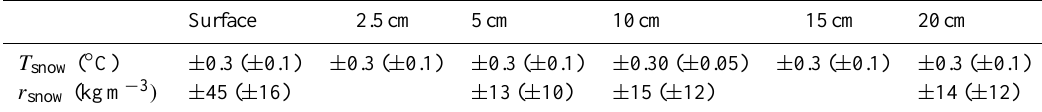
Table 2. Uncertainties on the vertical profiles of snow temperature ( T snow ) and density ( r snow ) , calculated as the square root of the sum of the squares of instrumental error and intra-pit variability. The intra-pit variability is given in